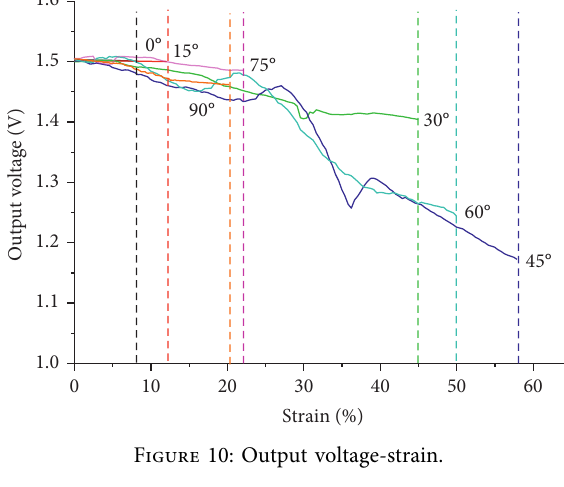
Figure 9: Tensile stress-strain curves of PV-PVC strip specimens.